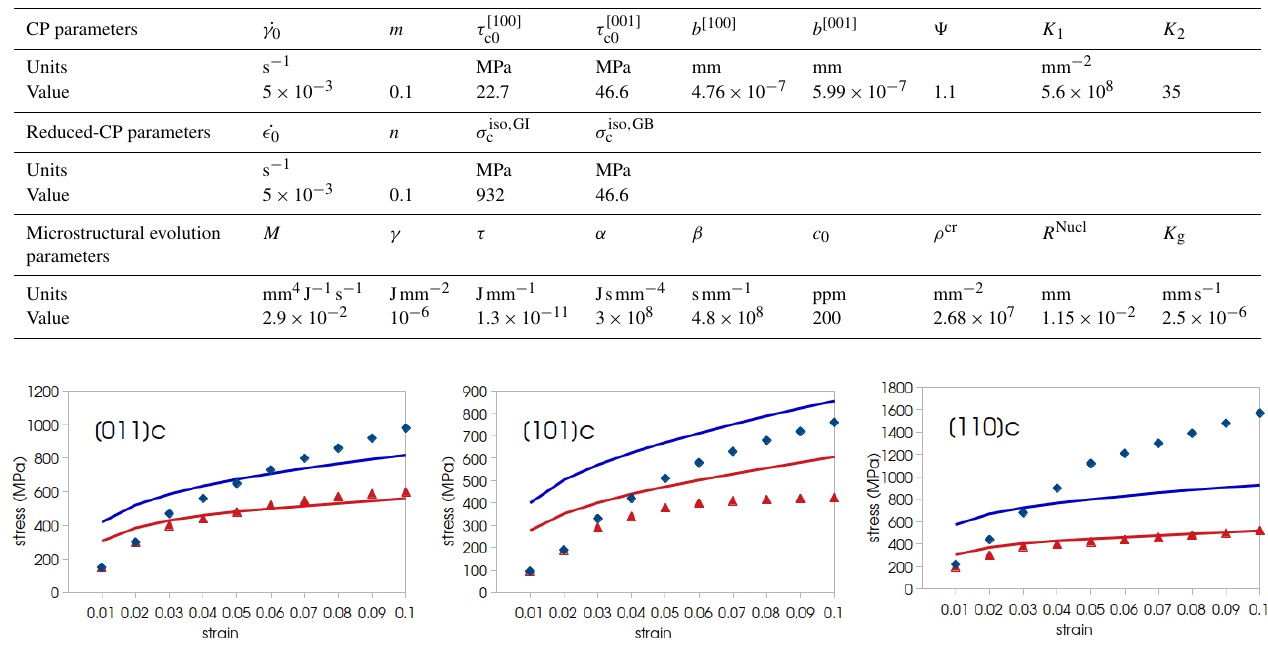
Figure 2. Best fitting strain–stress curves for hardening and recovery parameters calibration. Solid lines represent the simulated mechanical behavior while dots represent experiments of Phakey et al. (1972). For the three different orientations the colors represent the temperature of the compression test, 1073K (blue) and 1273K